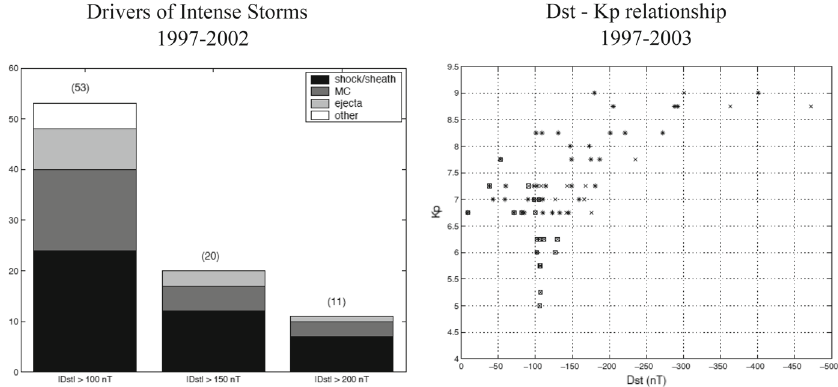
Fig. 33 (Left) Drivers of magnetic storms for three different Dst limits. (Right) The minimum Dst versus the maximum Kp for intense storms (Kp ≥ 7 and/or Dst < − 100nT) for 1997–2003. Note that in several cases the storm is defined as “intense” only by one of the used indices, while the other indicates more moderate activity (see discussion by Huttunen et al. 2002 and Huttunen and Koskinen 2004). Sheath storms are shown by asterisks and magnetic cloud storms by crosses. The rectangles show the cases that did not fulfill the Gonzalez et al. (1998) intense Kp criterion for an intense storm, i.e., the requirement that Kp has to be ≥ 6 at least for three 3-h periods. Images reproduced by permission from [left] Huttunen and Koskinen (2004), copyright by the authors; [right] Koskinen and Huttunen (2006), copyright by